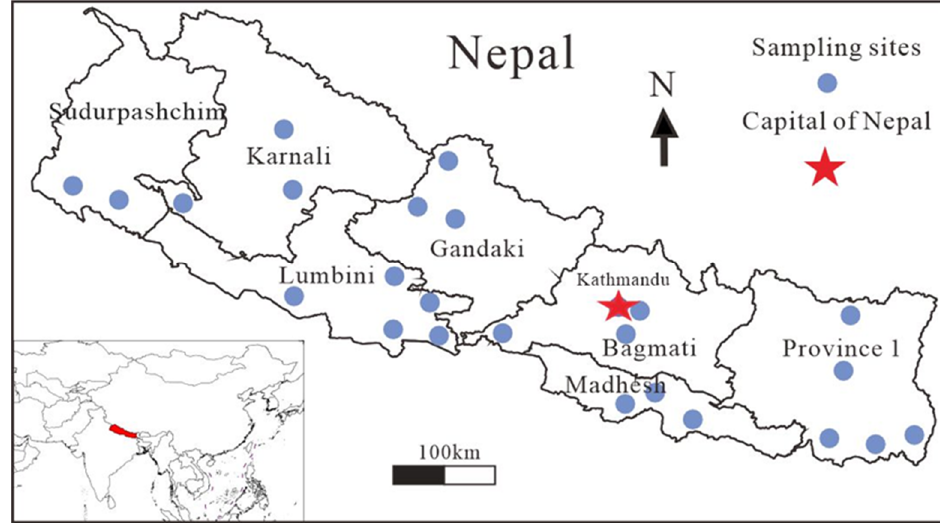
Figure 1. Sampling sites in different provinces of Nepal.